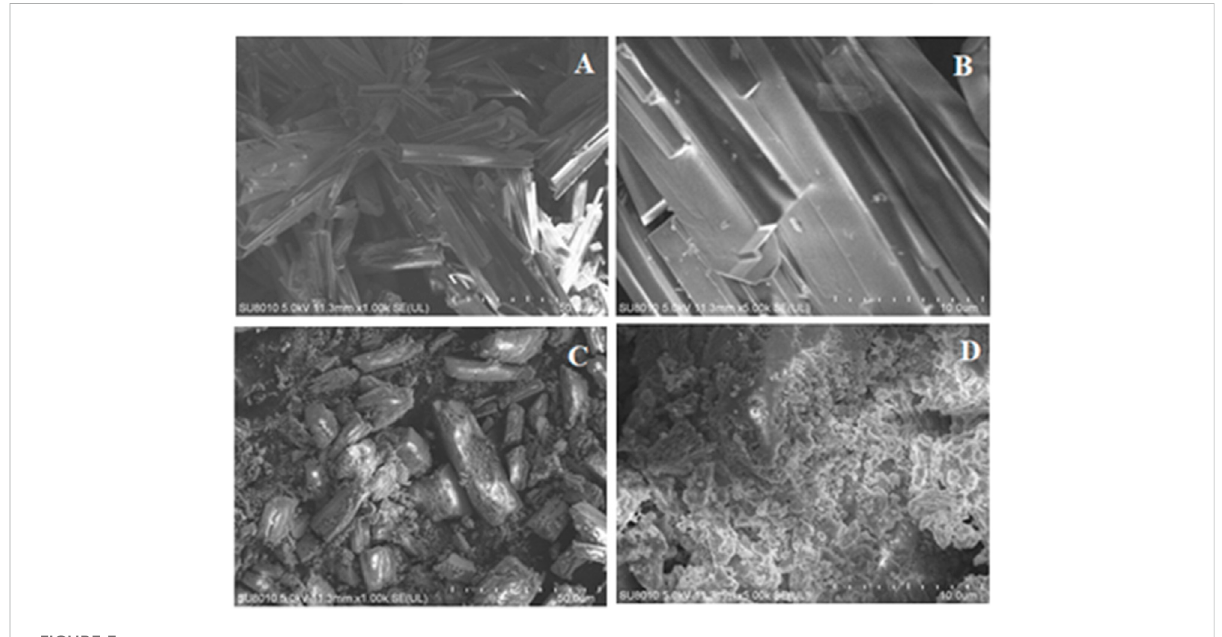
FIGURE 3 SEM images for (A,B) Ce-MOF and (C,D) GO@Ce-MOF